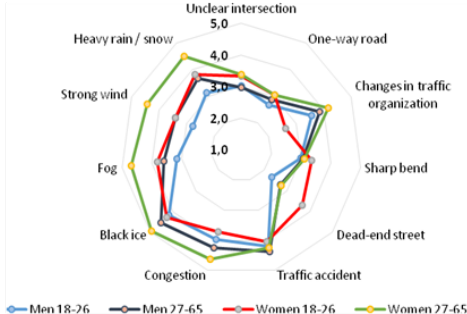
Figure 7. Evaluation of the importance of warning for driver about dangerous traffic